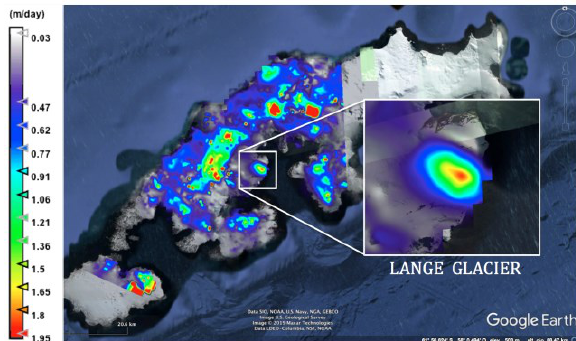
Figure 7: Color-coded merged velocity field obtained from both sides of the glacier (Cardenas et al.,